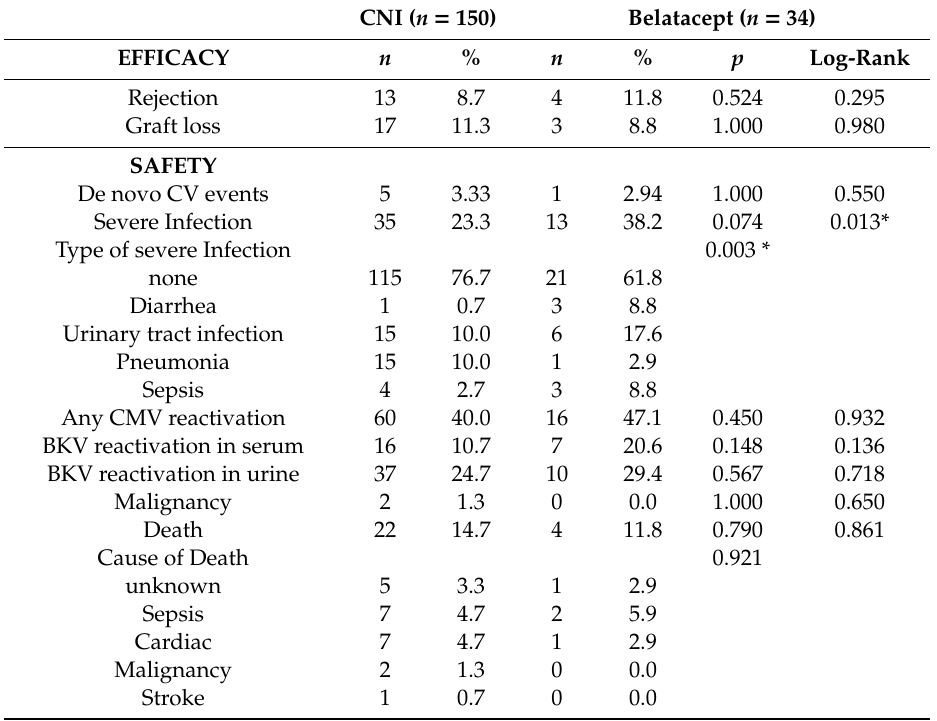
Table 5. E ffi cacy and safety endpoints at last follow-up. p -values < 0.05 are marked with an asterisk *. CMV: cytomegalo virus, BKV: polyoma